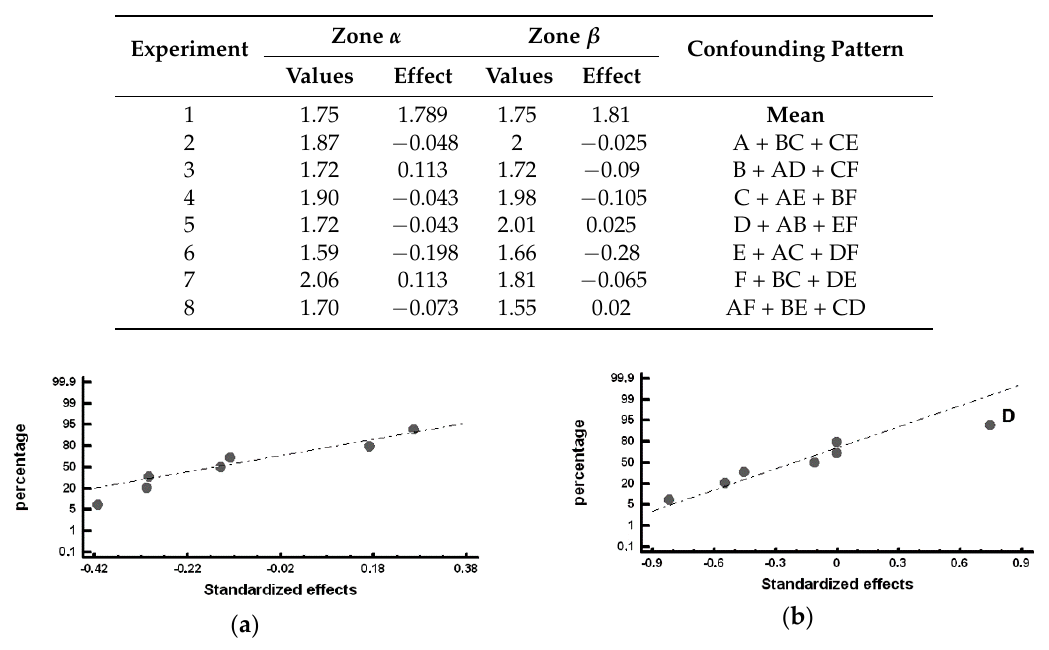
Table 9. Mean values and standardized effects for the Roundness parameter ( R ). Experiment